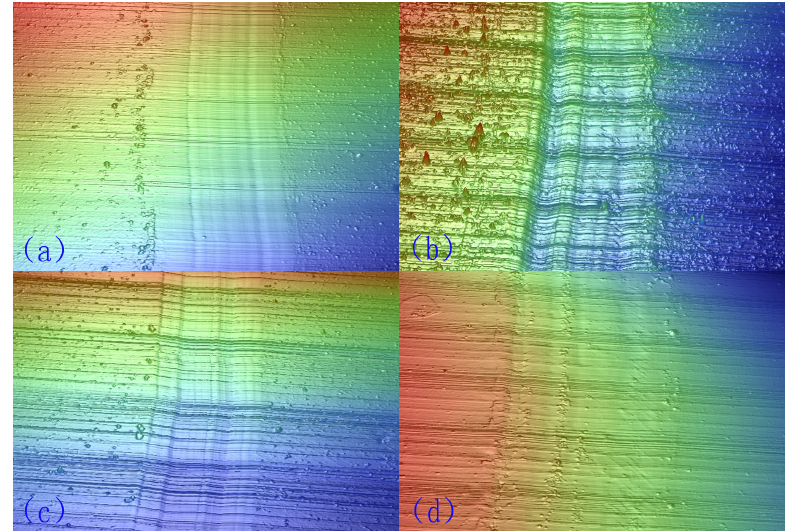
Figure 8. 3D wear track morphologies of Cr ‐ Ti ‐ B ‐ N films: ( a ) Cr 48.6 Ti 1.7 B 2.4 N 47.3 ; ( b ) Cr 43.9 Ti 2.4 B 4.0 N 49.7 ; ( c ) Cr 38.7 Ti 3.7 B 6.4 N 51.2 and ( d ) Cr 33.4 Ti 5.3 B 7.6 N 53.7 .